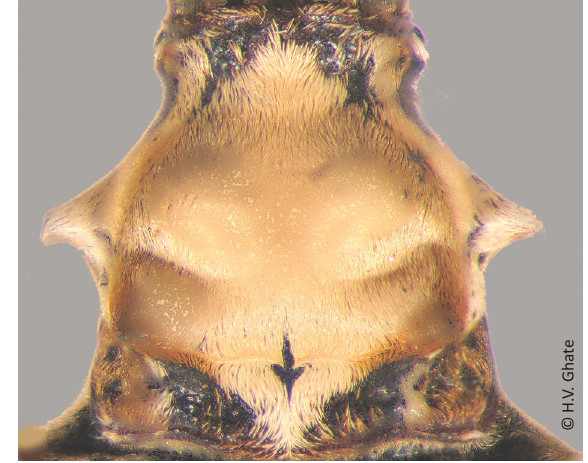
Image 5. Dorsal view of prothorax of Apiocephalus ; note pubescence, tubercles and the small cross mark at the base.